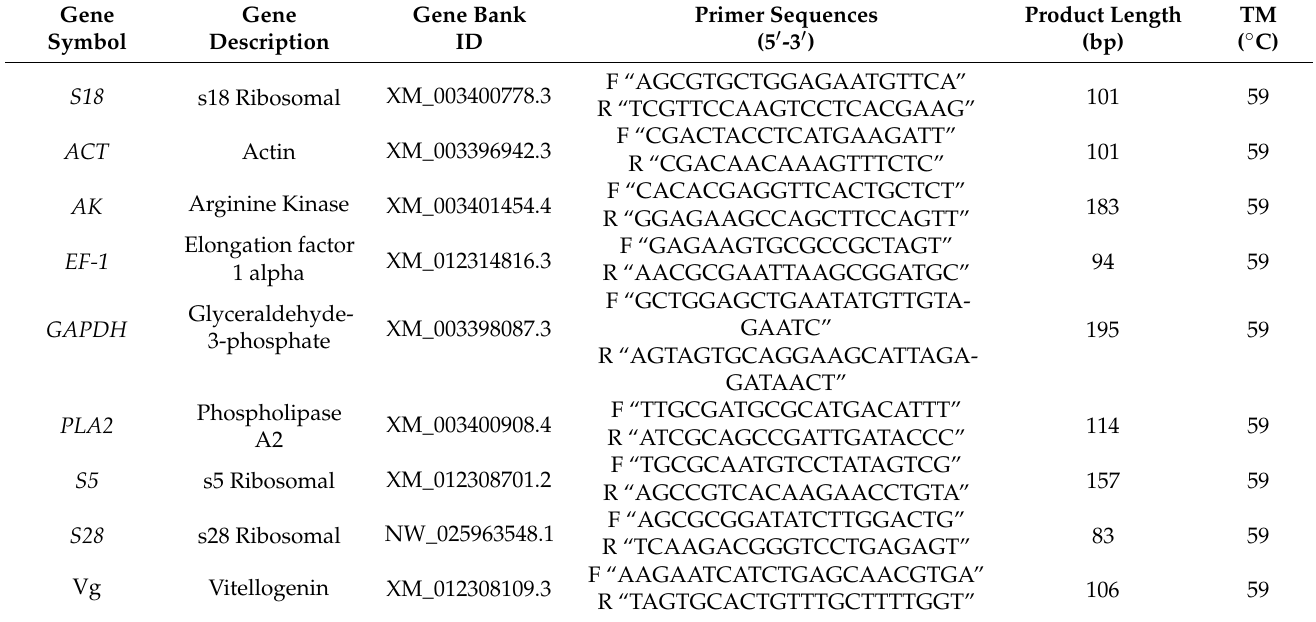
Table 1. Primer sequences and accession numbers of the eight candidate reference genes and the target gene in bumble bees. F: forward; R: reverse; TM: annealing